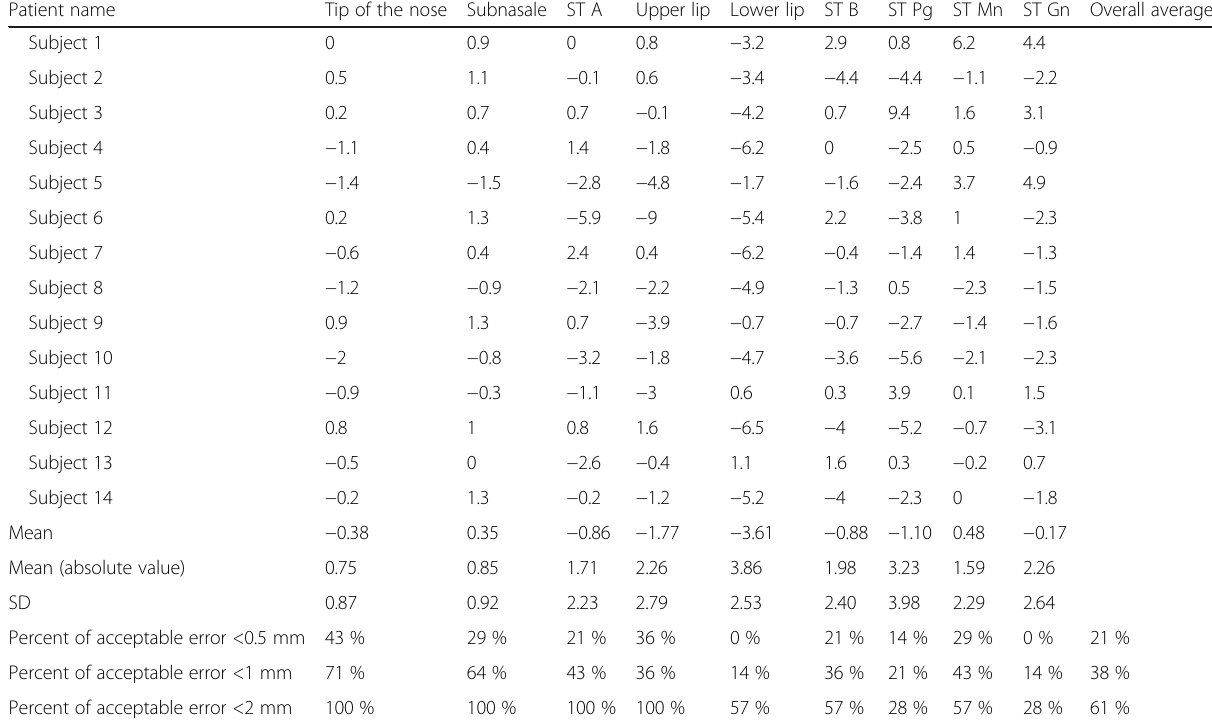
Table 3 Error of frequency of subjects and range of acceptable error in the Y